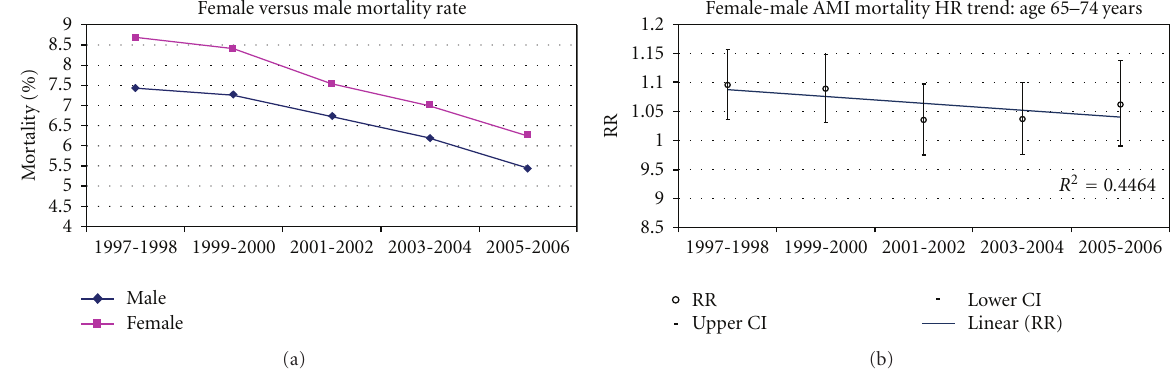
Figure 3: In-hospital AMI mortality rate and relative mortality trend (female versus male) by NIS year for age 65–74 years.